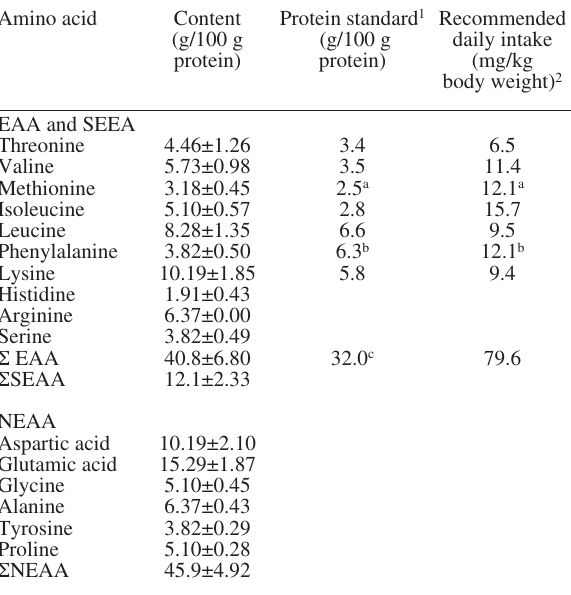
Table 3. – Mineral content (mg/100 g wet weight muscle; mean ± standard deviation), range of black scabbardfish muscle and recom- mended daily intakes (rdi).